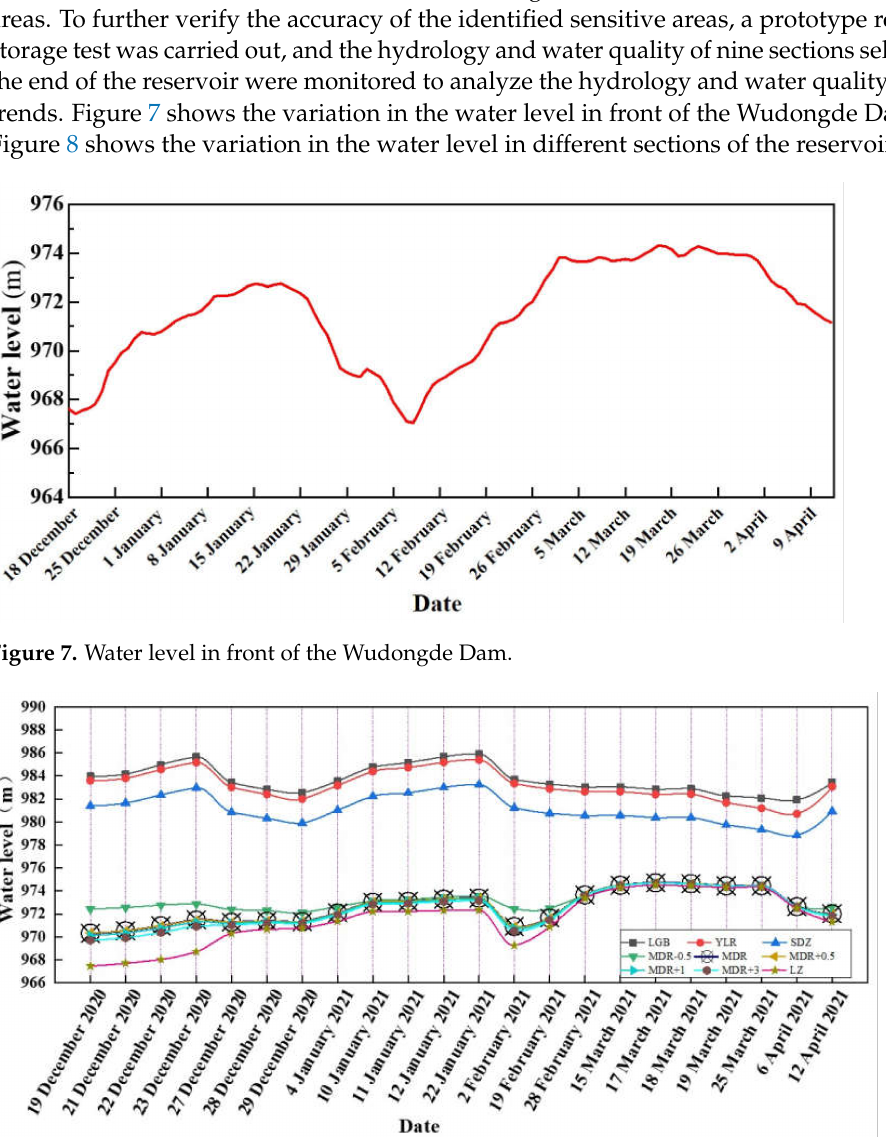
Figure 8. Variation in the water level in typical sections of the reservoir tail in Wudongde Reservoir. Luoguo Bridge, LGB; Yalong River, YLR; Sanduizi, SDZ; 0.5 km upriver of Madian River, MDR − 0.5; Madian River, MDR; 0.5 km downstream of Madian River, MDR + 0.5; 1 km downstream of Madian River, MDR + 1; 3 km downstream of Madian River, MDR + 3; Lazha,